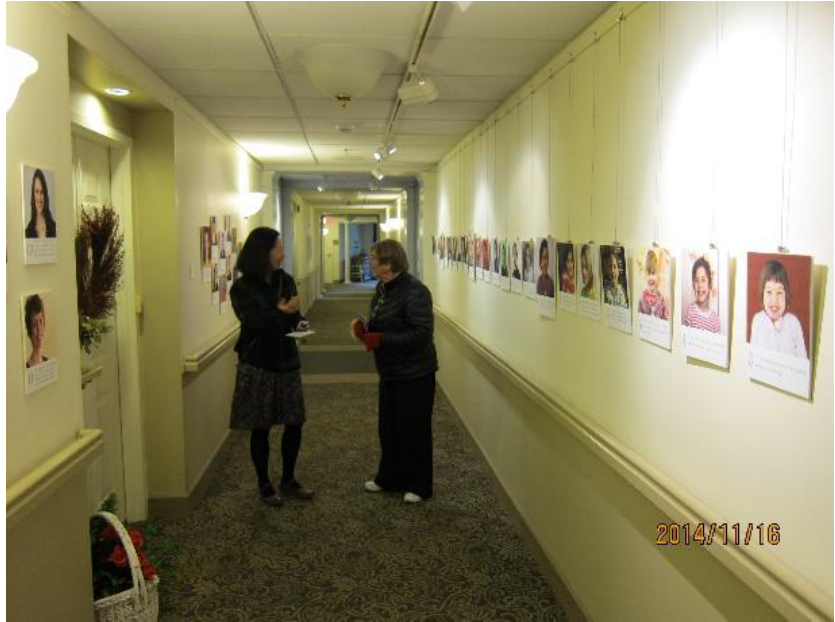
Figure 6: Exhibit in a large hallway of a facility for the elderly (Lititz, USA, November 2014 courtesy of the author) Conclusion: continuing to weave aging-friendly